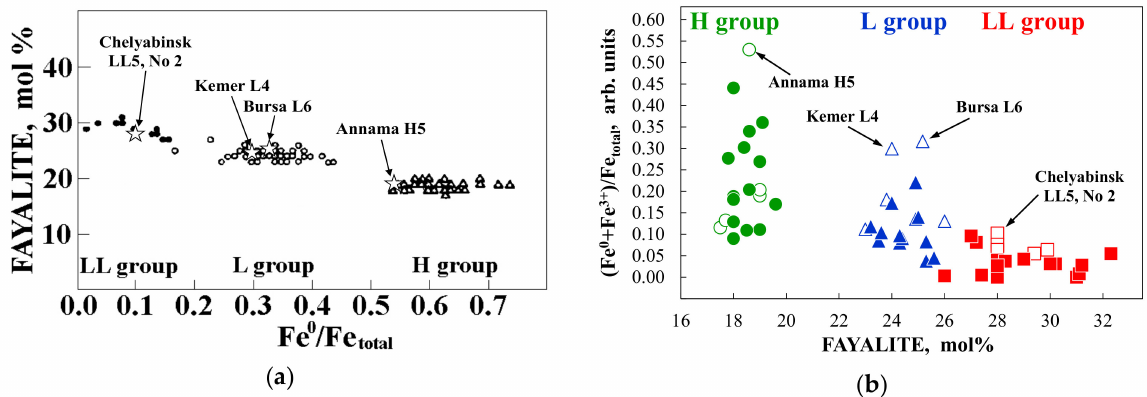
Figure 45. Classifications of H, L, and LL ordinary chondrites using the plot of fayalite vs. the Fe 0 /Fe total (Adapted from Reference [36]) with indication of Chelyabinsk LL5, No 2, Kemer L4, Bursa L6 and Annama H5 positions using the initial relative metallic iron fractions obtained from Mössbauer spectroscopy in [84,99,100,105] by asterisks and arrows ( a ) and the plot of the initial relative metallic iron fraction (Fe 0 +Fe 3+ )/Fe total obtained from the total relative areas of metallic phases plus ferric compounds vs. fayalite ( —H ordinary chondrites, —L ordinary chondrites, —LL ordinary chondrites data obtained by Mössbauer spectroscopy with a low velocity resolution, data were taken from [56,61,62,87,105,119–122]; —H ordinary chondrites, —L ordinary chondrites, —LL ordinary chondrites data obtained by Mössbauer spectroscopy with a high velocity resolution, data were taken from [100,101,107,112]), symbols corresponding to Chelyabinsk LL5, No 2, Kemer L4, Bursa L6, and Annama H5 are indicated accordingly ( b ). Fayalite values were taken from